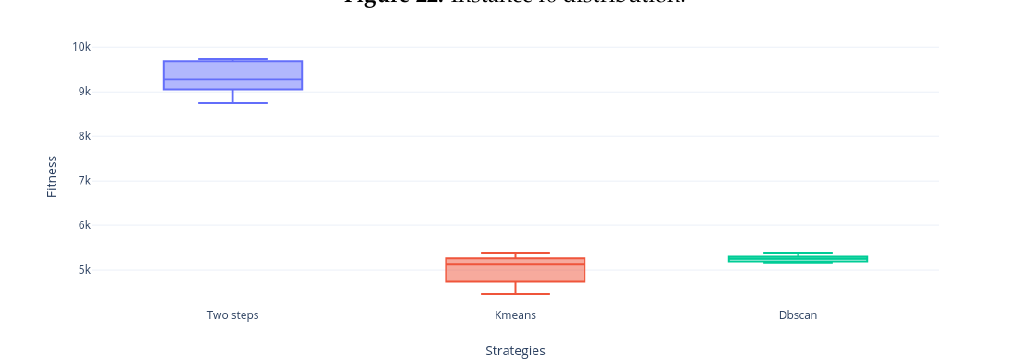
Figure 22. Instance f6 distribution.